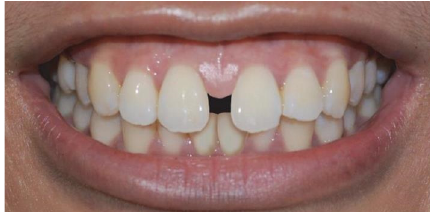
F IGURE 4: Photograph of digitally manipulated 4.0mm maxillary midline